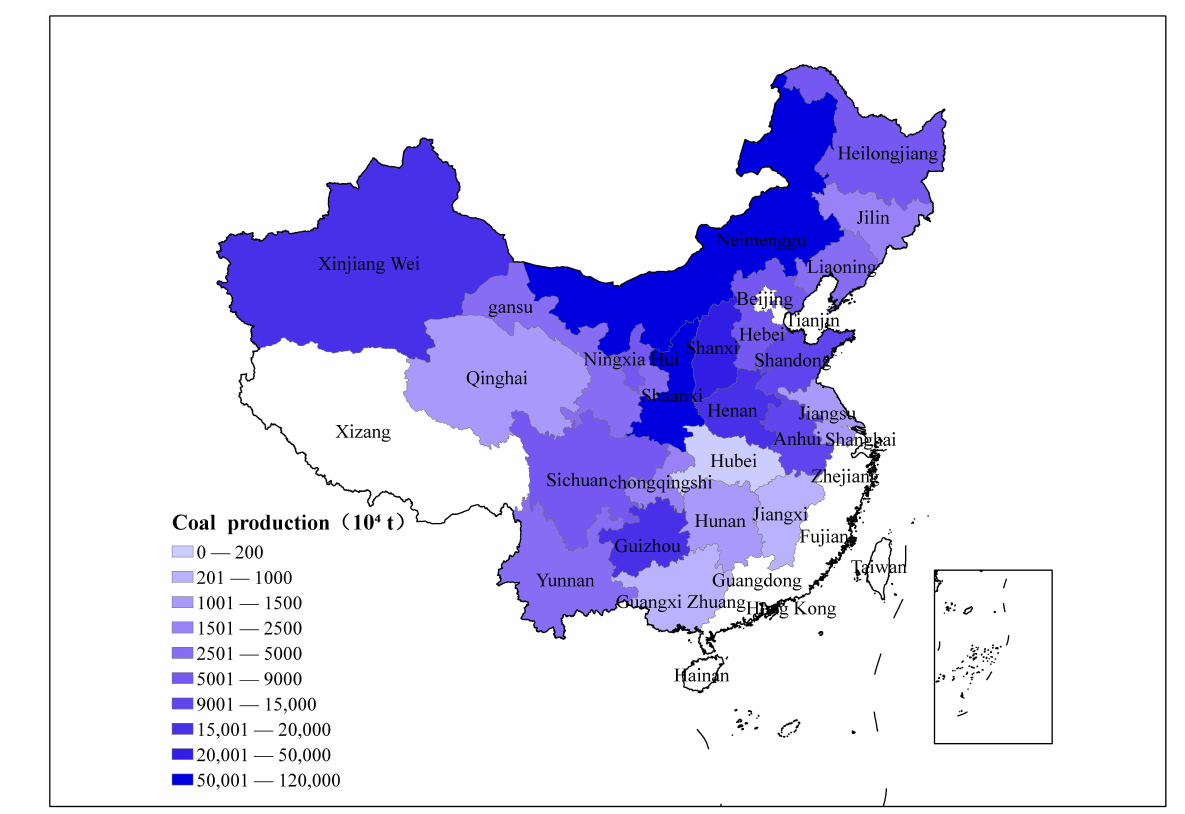
Figure 4. Coal production in various provinces.